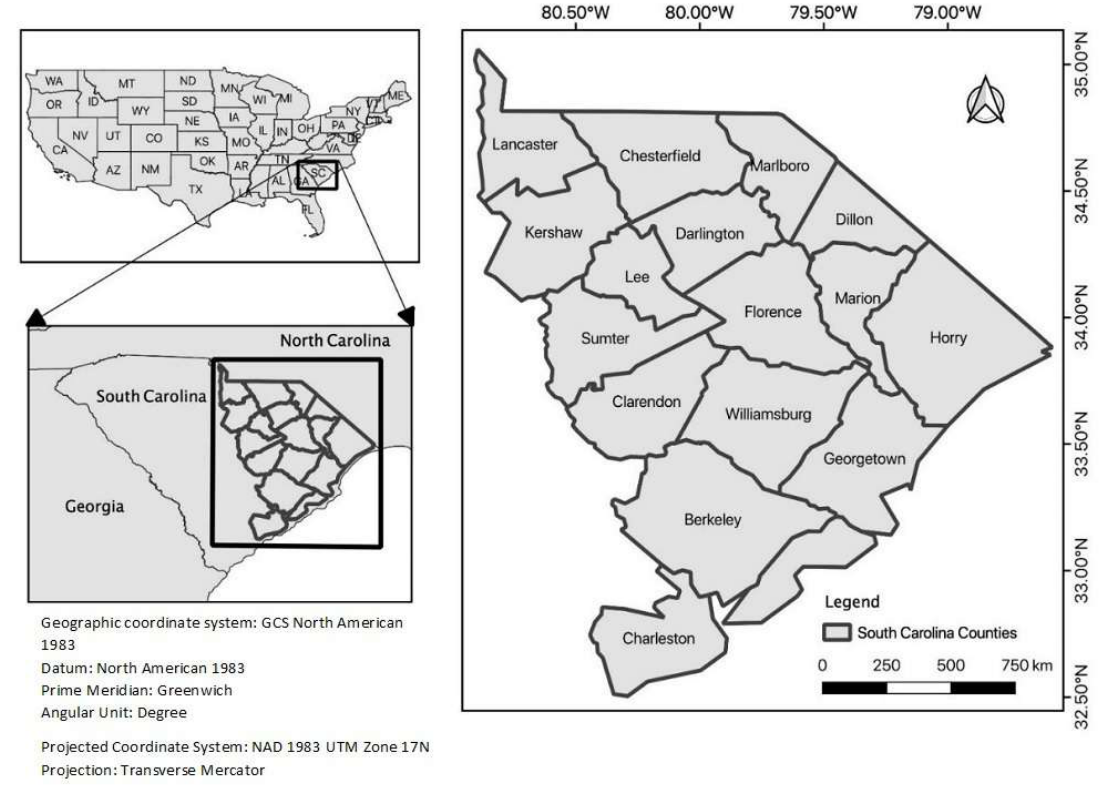
Figure 1. Location of the study area (30,408 km 2 ), Coastal South